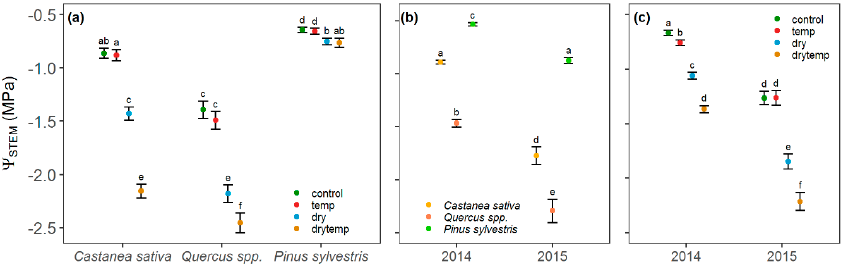
Figure 3. Variation of mean estimated stem water potential ( Ψ STEM ) and their standard errors induced by ( a ) species and treatment; ( b ) species and year, as well as ( c ) treatment and year. Estimates within each panel that do not share the same letter are significantly different at p < 0.05.